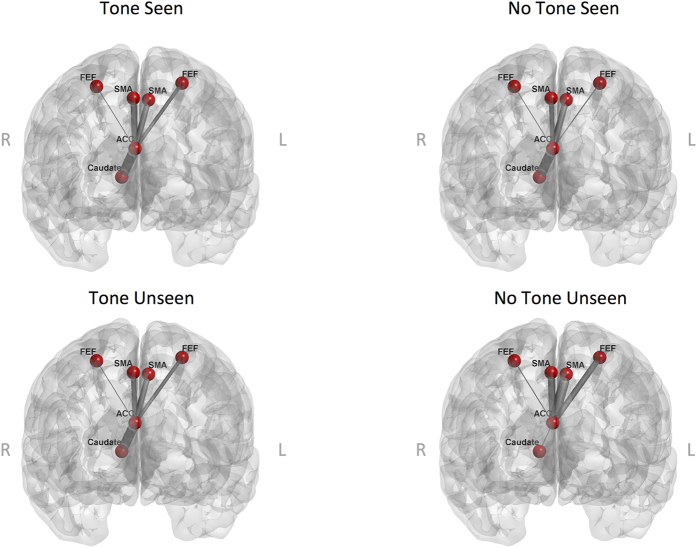
Pairwise functional connectivity for regions demonstrating a significant interaction between Alerting State and Awareness in the ANOVA of the beta-correlation values.Line thickness represents the coupling strength among regions.